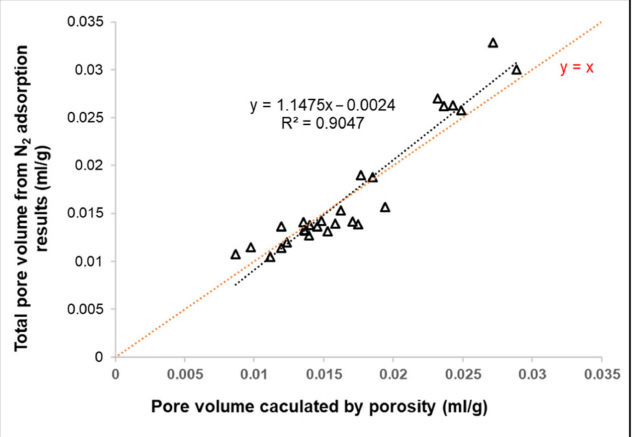
Figure 12. The plots of total pore volume from N 2 adsorption and pore volume calculated by porosity. Total pore volume = Micropores + Mesopores + Macropores; Calculated pore volume = (1/ ρ rock ) ×